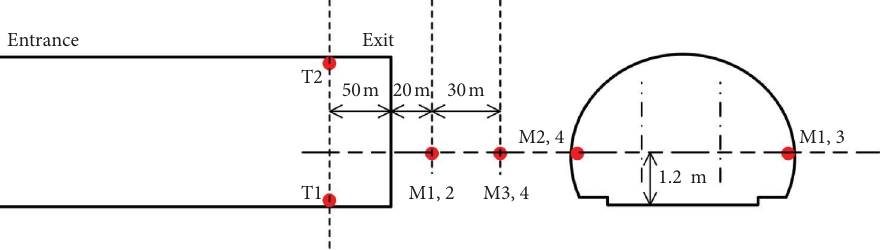
Figure 4: Layout monitoring points.